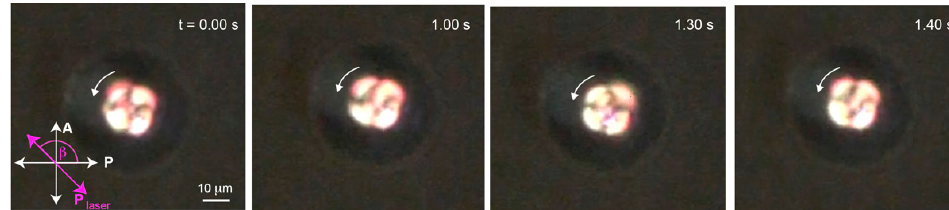
Figure 5. The same 19- μ m NLC droplet as in Figure 3 rotated in the reverse direction under the same linearly polarized laser trap at a higher laser power of 635 mW (Supplementary video available).